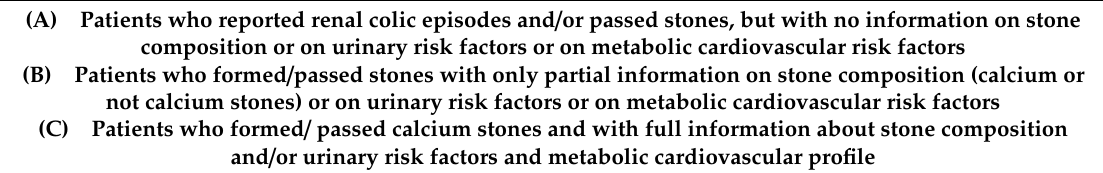
Table 1. Three possible scenarios of clinic presentation of patients with history of kidney stone